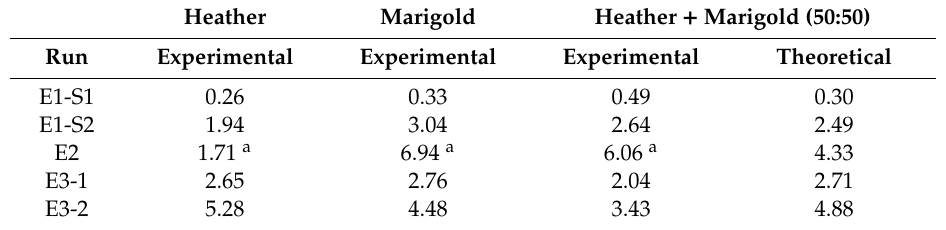
Table 2. Overall extraction yield (mass of extract / mass of plant × 100) obtained from SFE of heather, marigold and combined heather + marigold (50:50) extraction. Theoretical extraction yields are expressed as the arithmetic mean of the experimental extraction yield obtained from each individual plant. Heather Marigold Heather + Marigold (50:50) Experimental